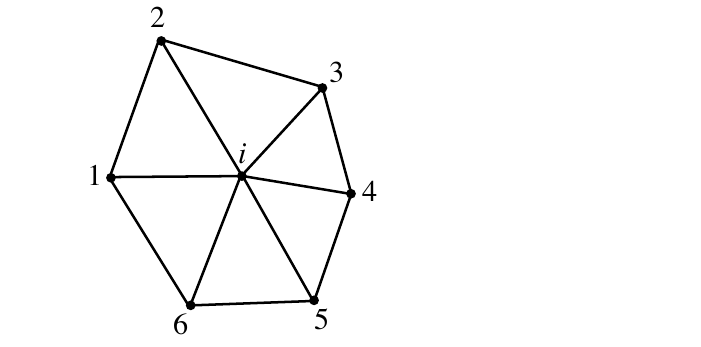
Figure 1. Finite difference fan for mesh point i on a Delaunay mesh with neighbors